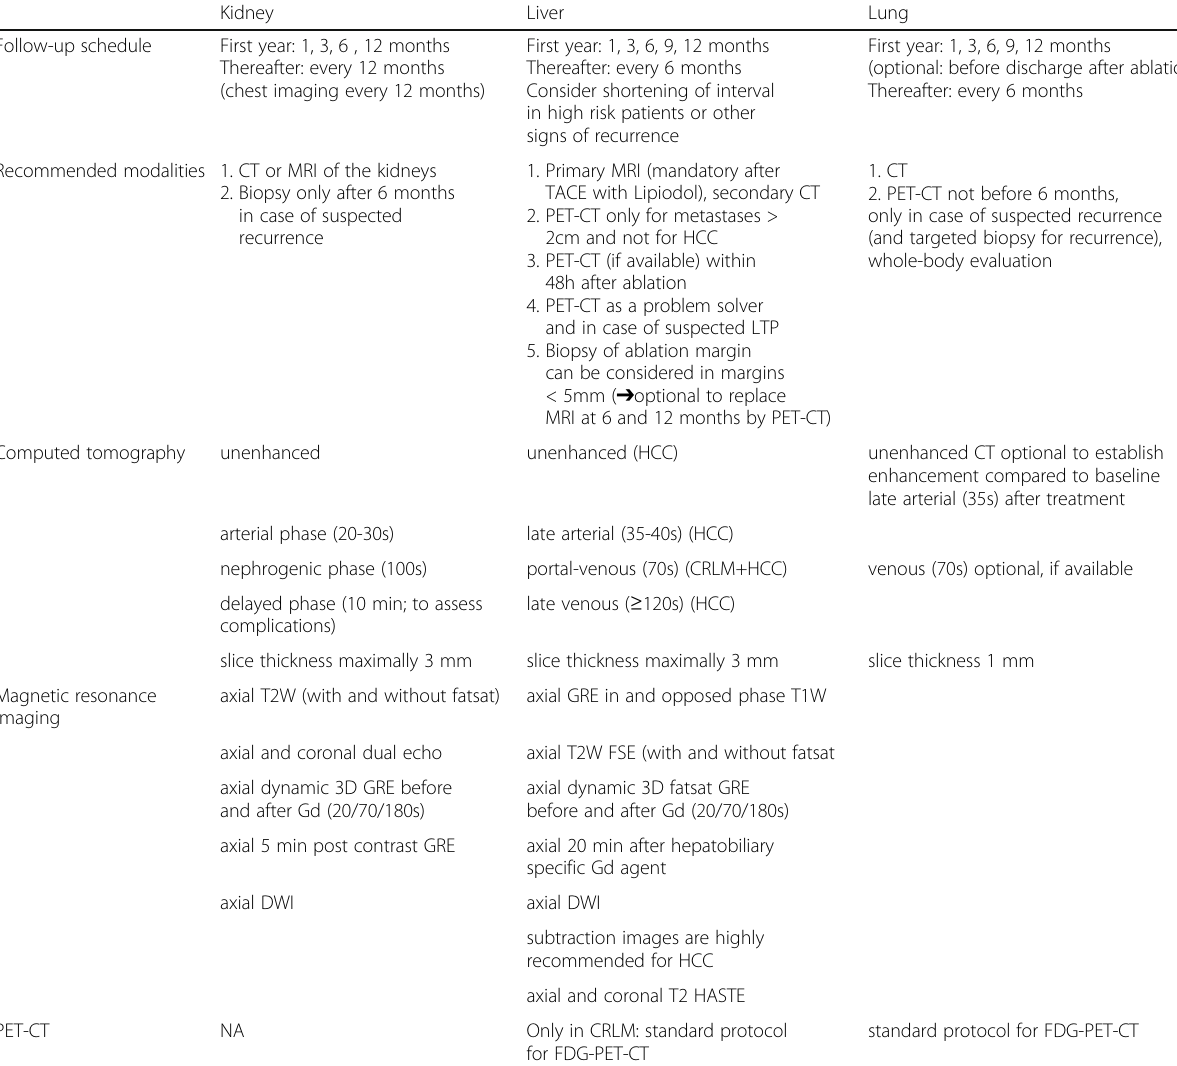
Table 2 Recommended imaging protocol and follow-up schedule